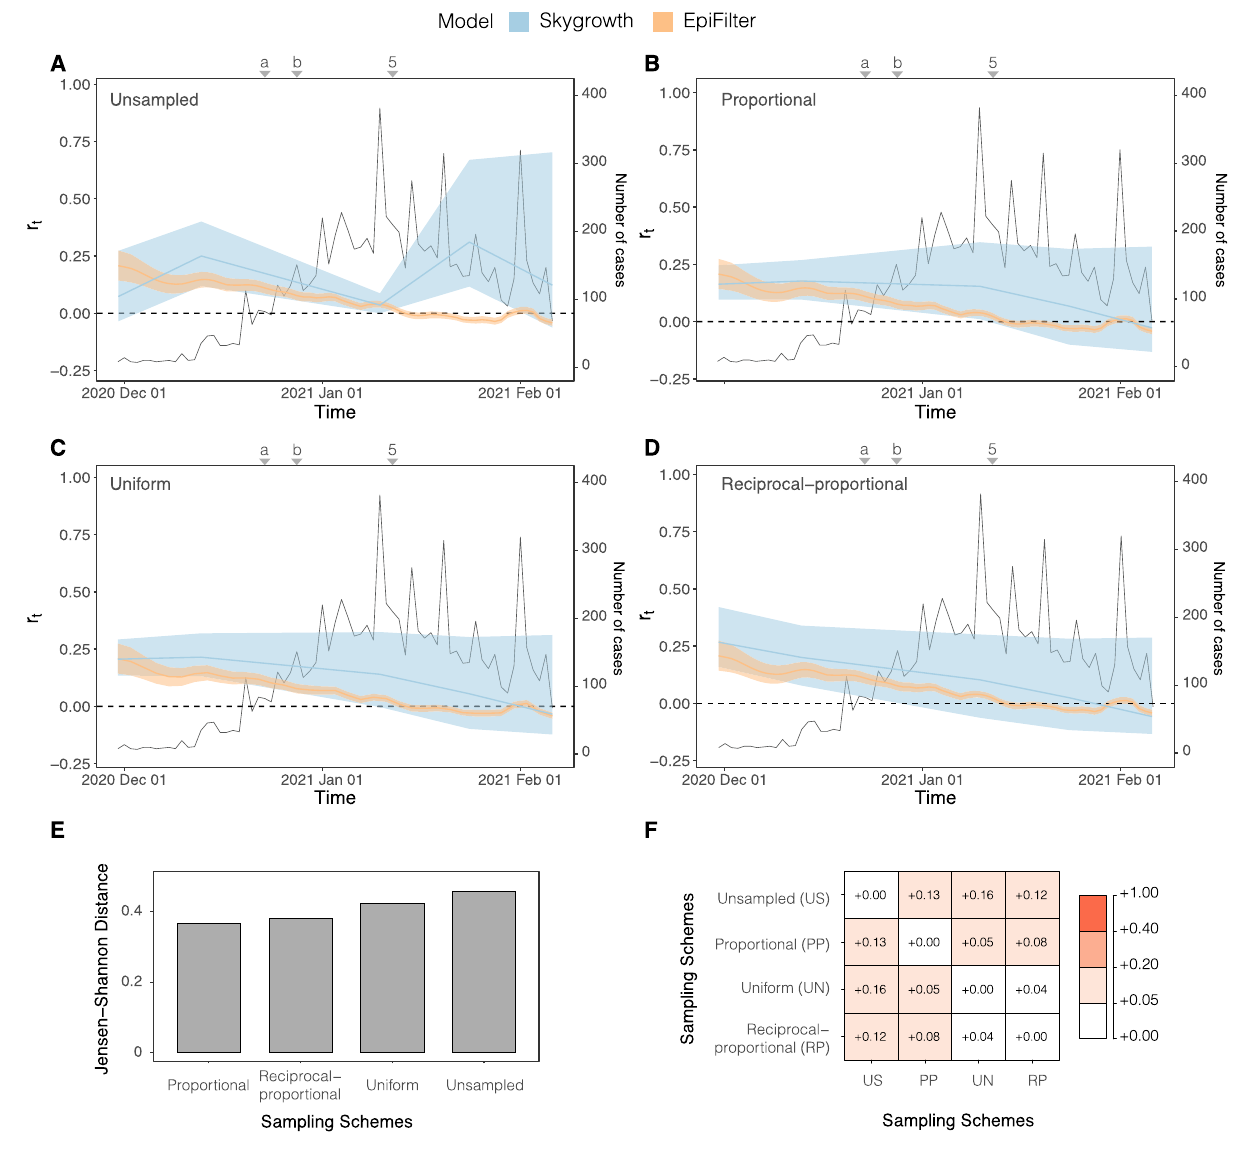
Fig. 7 | r t estimated from both the Skygrowth and EpiFilter methods for Ama- zonas, Brazil. Titles indicate the sampling scheme used in panels A – D . The light- shaded area represents the 95% highest posterior density interval. The solid line represents the mean r t estimate with EpiFilter in orange and Skygrowth in blue. We refertoFig.2forabriefdescriptionofkeyevents,including5whichcorrespondsto the second lockdown. Event “ a ” corresponds to the suspension of